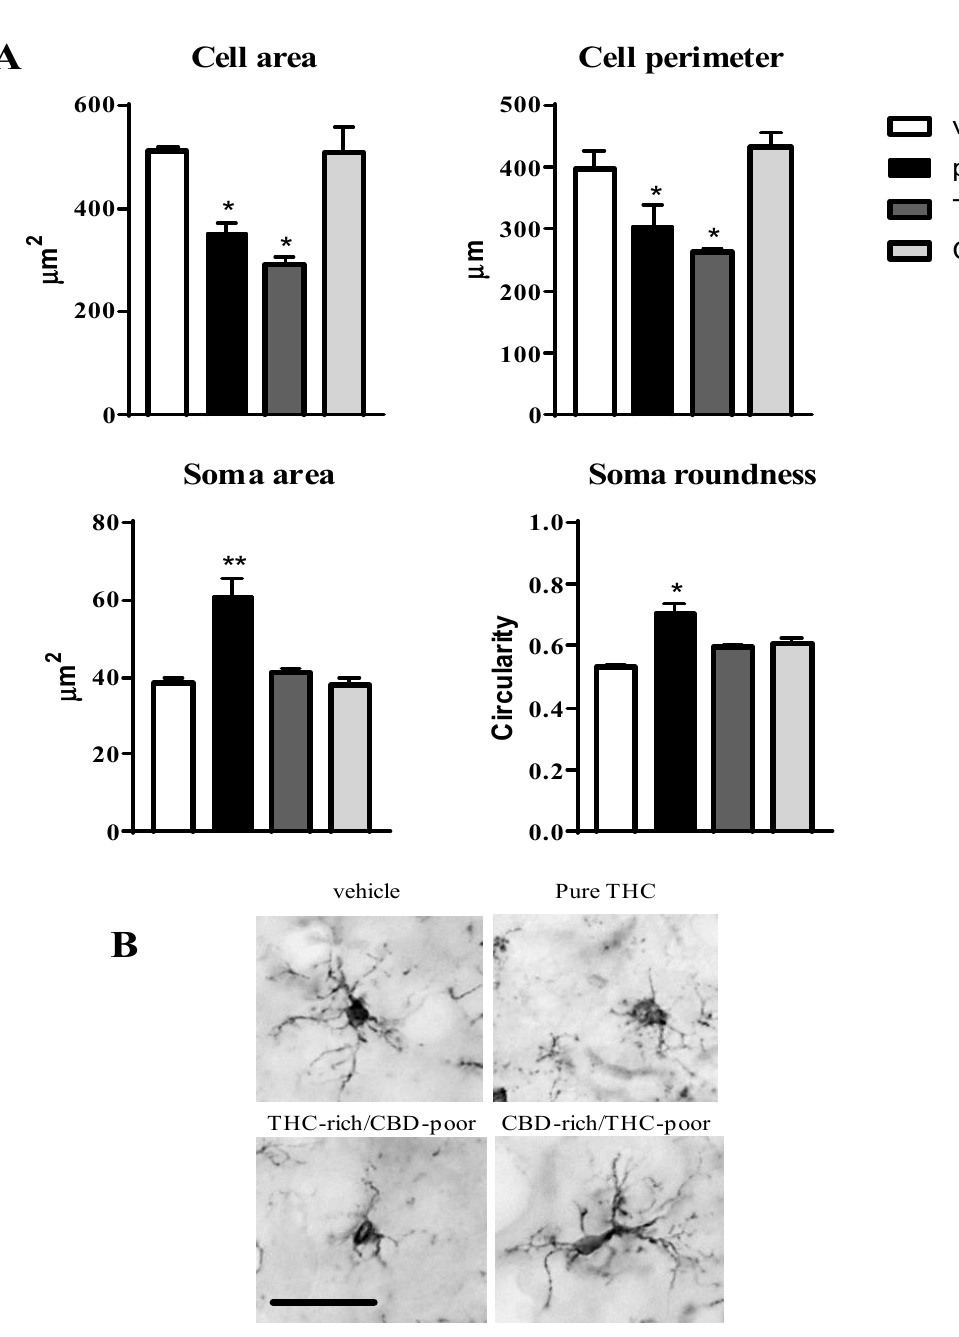
Figure 3. Effect of administration of adolescent THC and THC/CBD combinations on microglia morphology (cell area and perimeter, soma size and roundness (panel A ) in the adult prefrontal cortex as measured through Iba1 immunostaining. Representative pictures of Iba1-positive cells in the prefrontal cortex are reported in (panel B ); scale bar = 20 µm. Data are expressed as mean ± SEM of 3 animals per group (36 cells/group). ** p < 0.01, * p < 0.05 vs. vehicle. One-way ANOVA followed by Tukey’s post-hoc test.